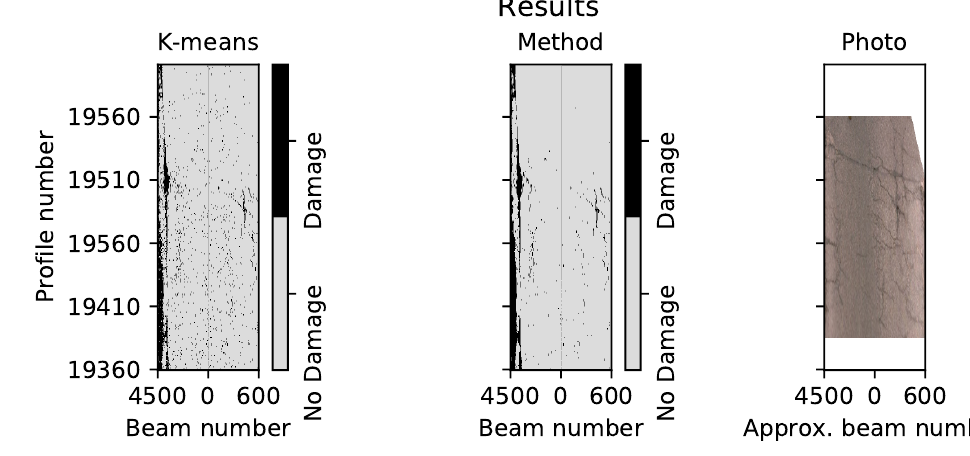
Figure 8. Examples of features. A: standard deviation of the numbers of neighbours, B: standard deviation of the range difference, C: deviation from the mean of Intensity with window size 41, D: Sum of different windows of the difference